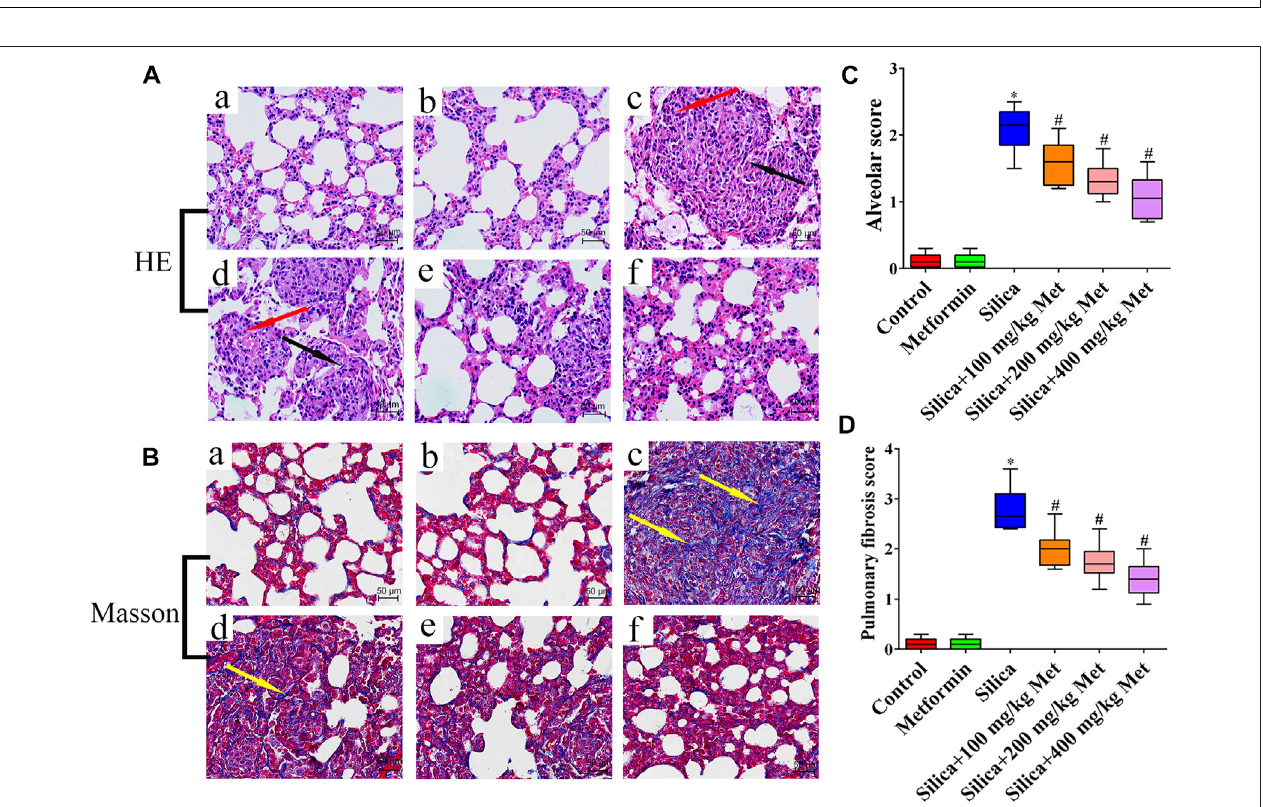
FIGURE2| Metforminreducesthein fl ammationandcollagenaccumulationinthelungtissueofsilicosisratcausedbysilica. (A) HEstainingoflungtissues(200 × mag.)The redarrowspointtothein fl ammatorycells.The fi broblastsarelabeledwithblackarrows. (B) Massontrichromestainingofcollagenonlungsections(200 × mag.).Theyellowarrow pointstothecollagen. (C-D) Quantitativeanalysisofratalveolitisand fi brosisscore. a Controlgroup; b Metformintreatmentgroup; c Silicagroup; d Silica+100 mg/kgmetformin group; e Silica+200 mg/kg metformin group; f Silica+400 mg/kg metformin group. * p < 0.05, compared to the control group; # p < 0.05, compared to silica group.